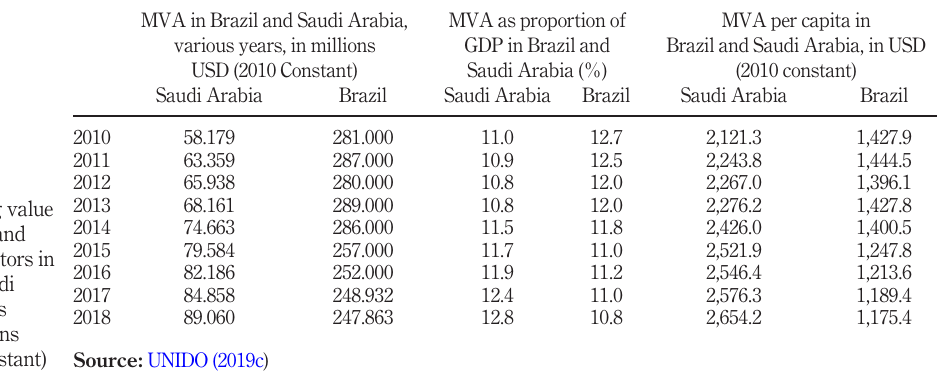
Table II. Manufacturing employment as a proportion of total employment (5%) in Brazil and Saudi Arabia